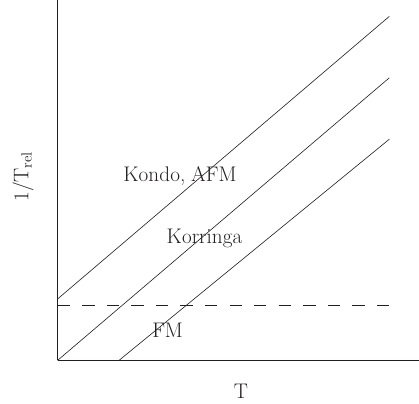
Figure 2. Sketch of the relaxation rate as a function of T for AFM or Kondo correlations, FM fluctuations and no interactions (Korringa). Close to a magnetic transition (either AFM or FM), there are additional relaxation mechanisms due to collective excitations (spin-waves or magnons) which have not been taken into account here. The horizontal dashed line schematically indicates the resonance energy. Only below that line is a signal